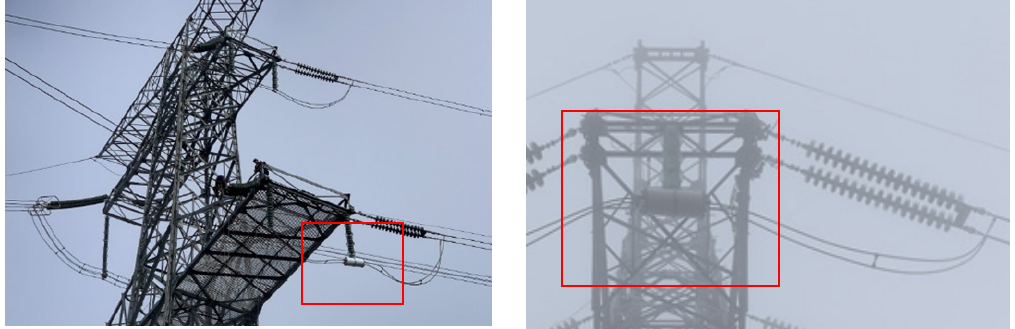
Figure 19. The CTIIMD operation diagram on site.